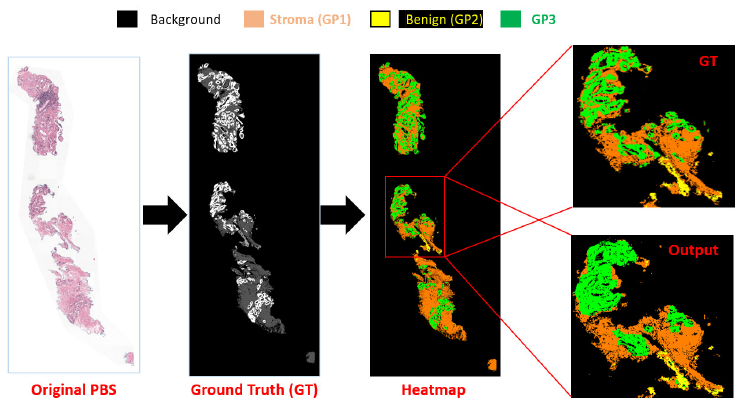
Figure 7. Examples of GP results from our deep learning